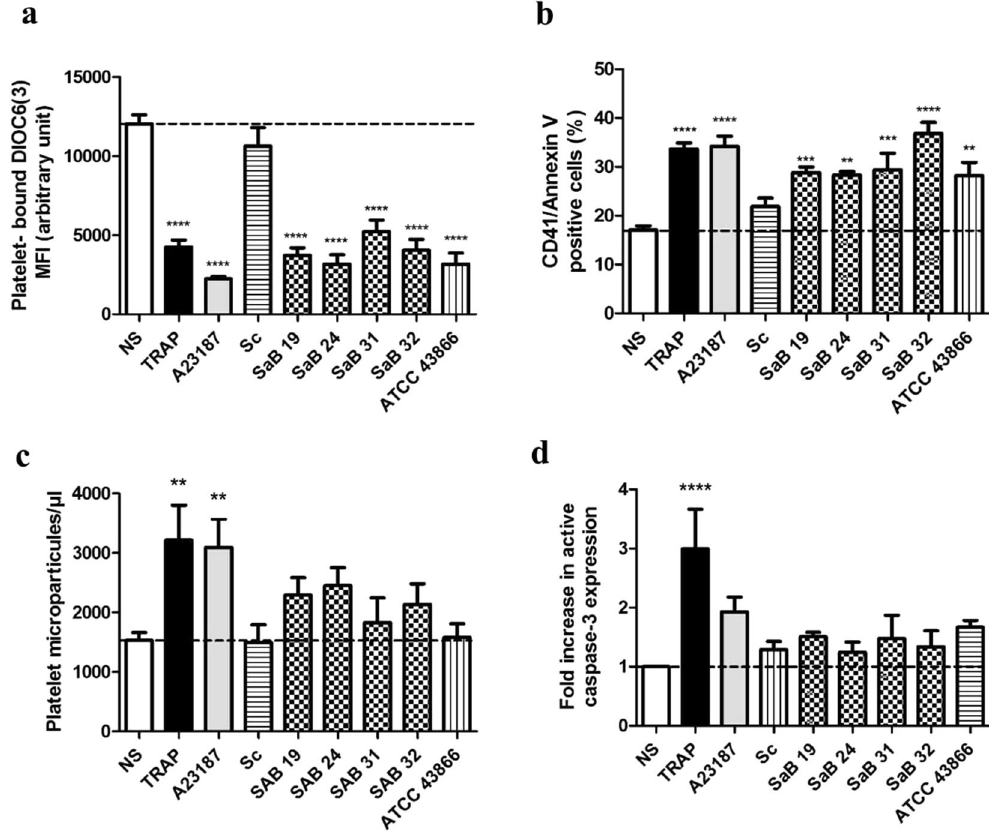
Figure 5. S. aureus -induced platelet cell death. ( a ) MFI of platelet-bound DIOC6(3) (b) Annexin V binding (c) PMP concentration or (d) fold increase in active caspase-3 expression were analyzed by flow cytometry after 30 min of exposure to Tyrode’s buffer (NS), TRAP, staphylococcal strains [clinical strains (SaB), S. condimenti (Sc) or S. aureus ATCC 43866 (ATCC43866)] or the A23187 apoptosis inducer as a positive control. The data (mean ± SEM; n = 8 experiments) are expressed as the AU ( a ), % expression ( b ) or fold increase compared with NS ( d ). The PMP concentration (mean ± SEM; n = 6–27 experiments) ( c) is expressed as microparticles/ µ l. * p < 0.05, ** p < 0.01, **** p < 0.0001 (one-way ANOVA with repeated measures and the Bonferroni post hoc test; stimulated vs . unstimulated,